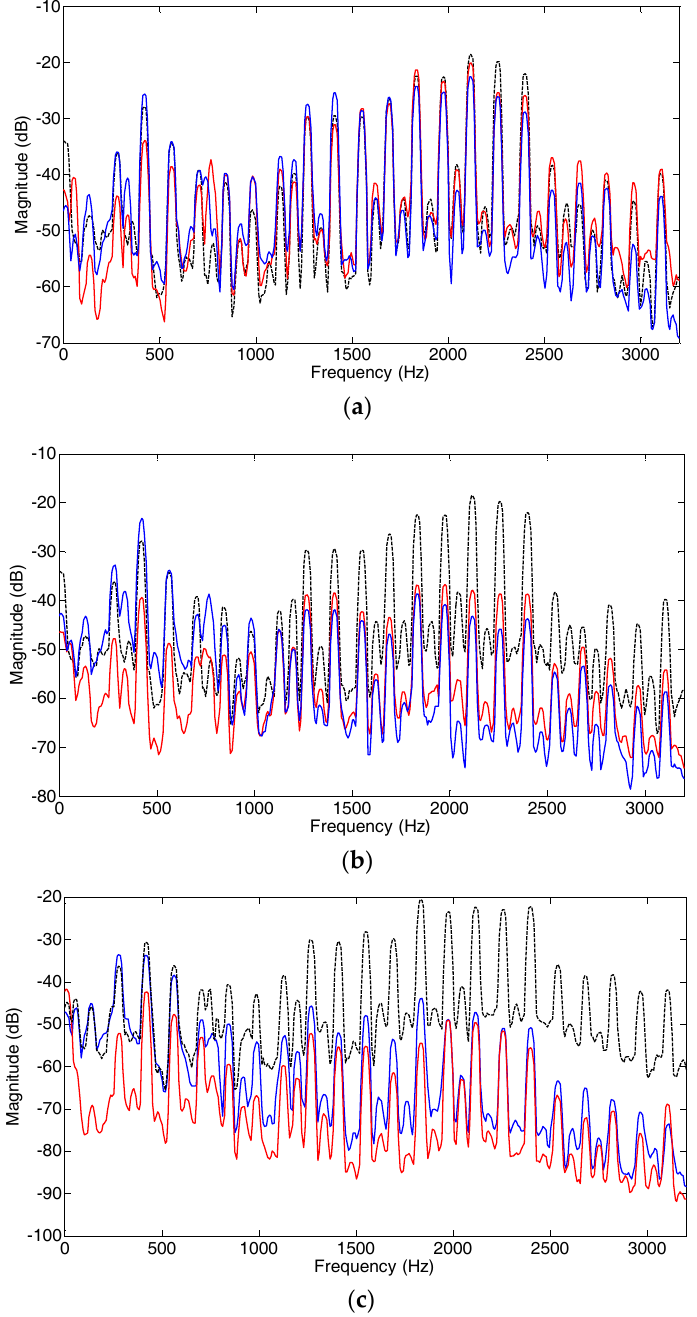
Figure 8. Spectra of noise measured at the KEMAR’s ear without earphone on it (black), with earphone but without ANC (blue), and after ANC is turned on (red). ( a ) Type A; ( b ) type B; ( c ) type C.